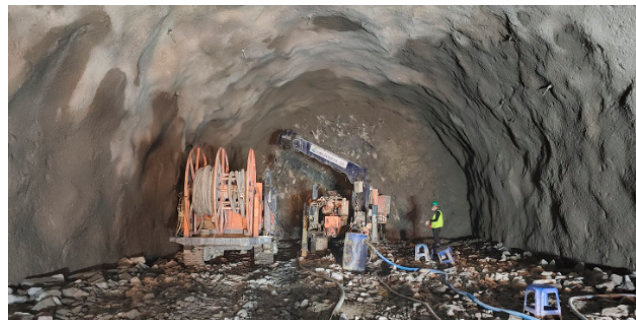
Figure 2. Photograph of field application of the LLB method at a tunnel construction site located in South Korea.